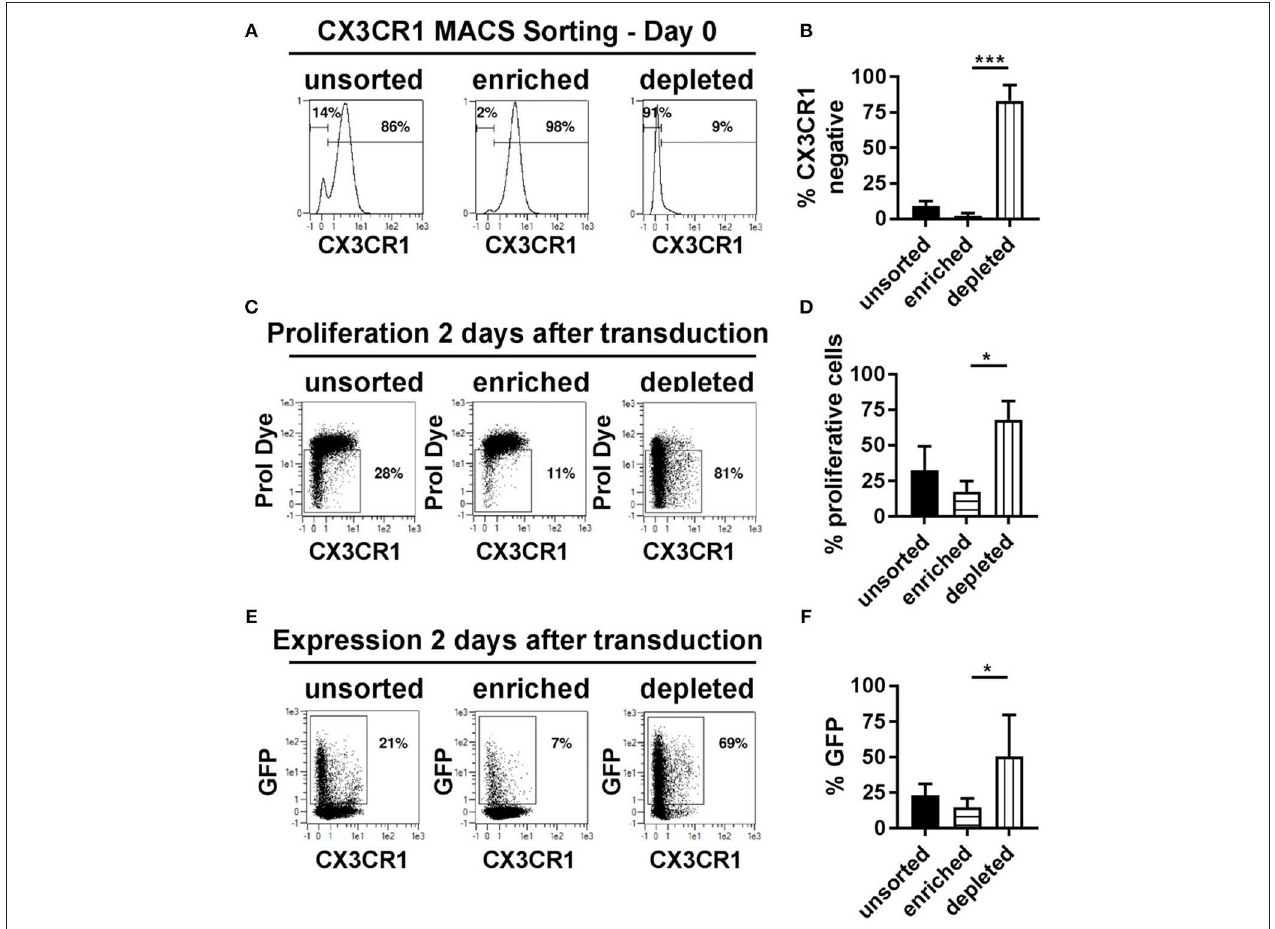
FIGURE 6 | CX3CR1 − subset of NK cells is highly proliferative and transducible. (A) Different NK cell subsets were separated based on their CX3CR1 expression using MCAS sorting prior to transduction and culture. (B) Average of three independent separation and expression of CX3CR1 in different separated NK cell population. (C) Representative figure for proliferation of unsorted NK cells, CX3CR1 + subset, and CX3CR1 − subset of NK cells are shown. (D) Average of the independent proliferation experiments. (E) Representative transduction efficiency of unsorted NK cells, CX3CR1 + subset, and CX3CR1 − subset of NK cells. (F) Average of three independent transduction experiment are shown. Unsorted, total NK cell isolated from PBMC; Enriched, CX3CR1 positive NK cells are sorted; Depleted, CX3CR1 negative NK cell subset collected from sorting. * P ≤ 0.05, *** P ≤ 0.0005.